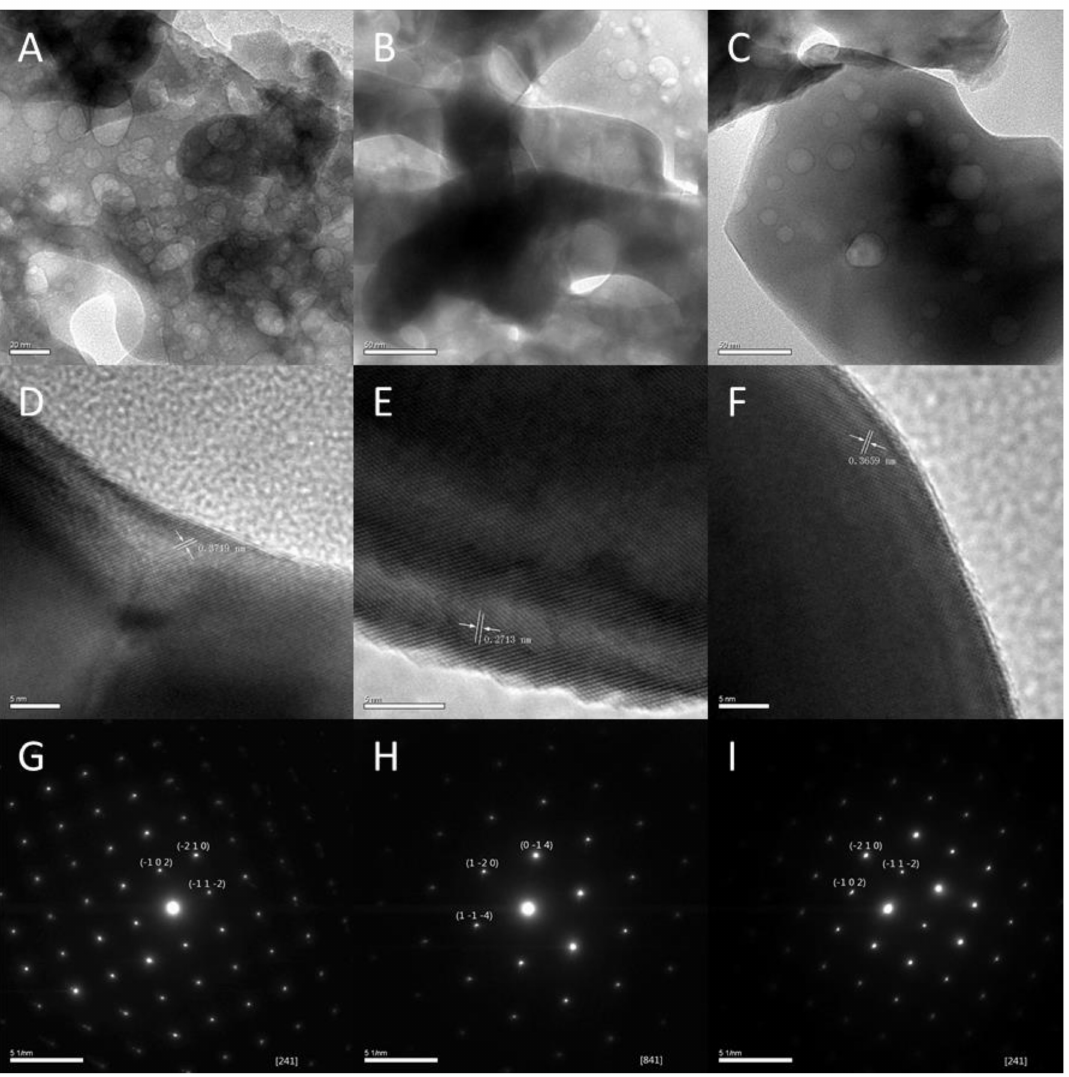
Figure 4. Transmission electron microscopy of samples calcined at ( A ): 500 ◦ C, ( B ): 600 ◦ C, and ( C ): 800 ◦ C. High-resolution transmission electron microscopy of samples calcined at ( D ): 500 ◦ C, ( E ): 600 ◦ C, and ( F ): 800 ◦ C. Selected area electron diffraction during high-resolution microscopy of samples calcined at ( G ): 500 ◦ C, ( H ): 600 ◦ C, and ( I ): 800 ◦